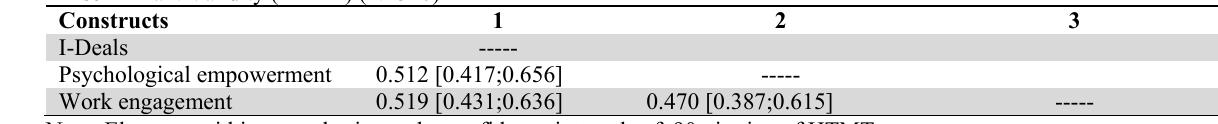
Discriminant Validity (HTMT)